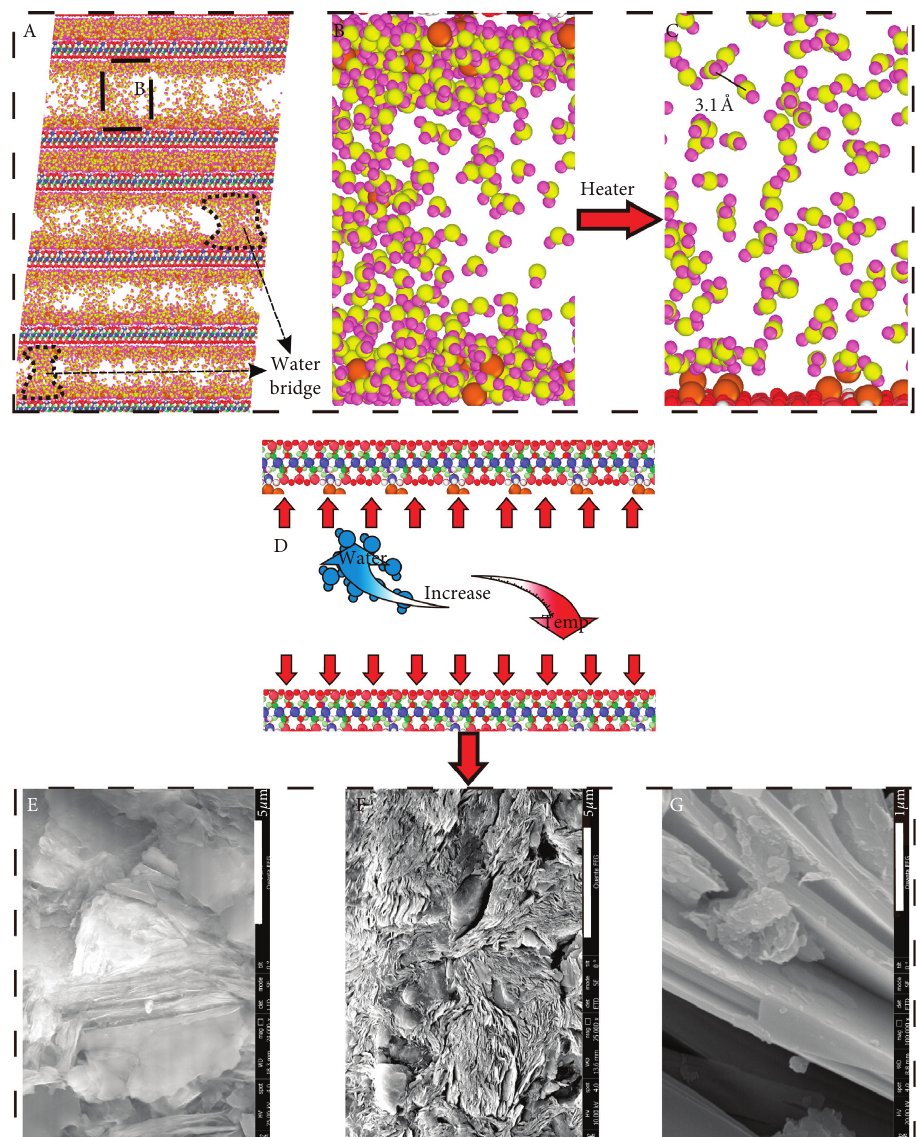
Figure 9: Evolutionary pattern of hydrated